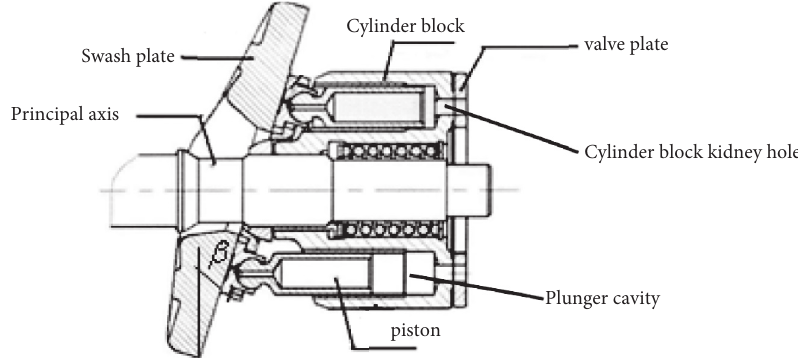
Figure 1: Structural representation of an axial piston pump [30].